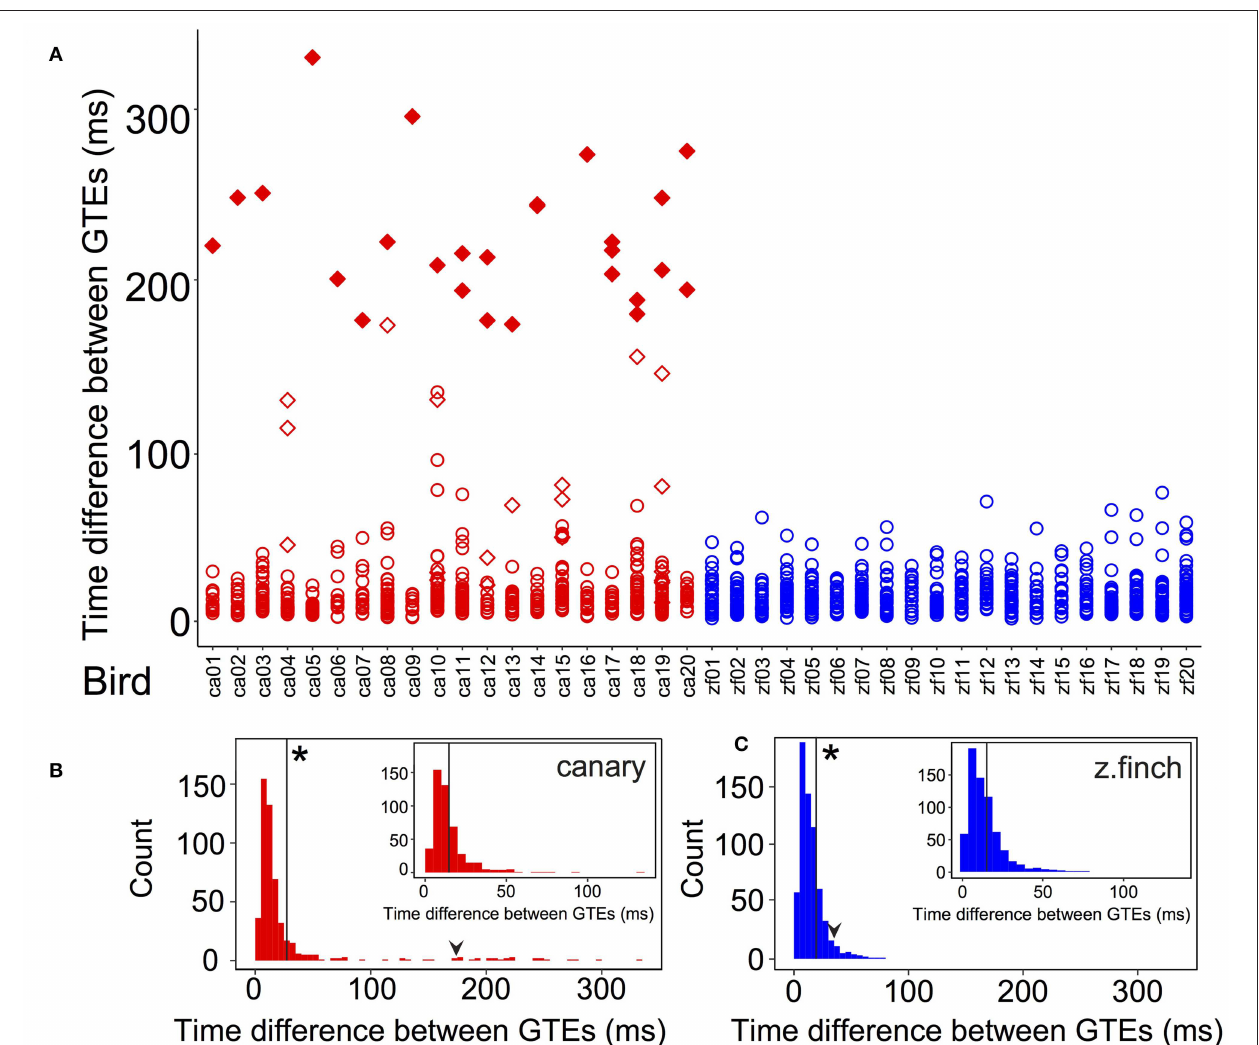
FIGURE 4 | Time differences between GTEs of each bird and grouped by species. (A) Time differences between GTEs for canaries (red markers) and zebra finches (blue markers). In canaries, diamonds indicate that the time difference belongs to a whistle syllable. Note that every canary has at least one diamond. The largest time differences of the canary distribution (in the 95th percentile, larger than 173ms) are indicated with filled markers. Every time difference included in this group was from a whistle. (B) Histogram (5ms bins) of time differences between consecutive GTEs in canaries and (C) in zebra finches. The black arrowheads show the value of the 95th percentile of each distribution (173ms for canaries and 35ms for zebra finches). The vertical black lines show the value of the mean of each distribution: 28.0 ± 2.2ms (mean ± SEM) for canaries ( n = 505) and 15.1 ± 0.4ms (mean ± SEM) for zebra finches ( n = 637). Asterisks in (B,C) indicate that these means were significantly different ( t -test, p < 0.01). In canaries, the longest GTE time interval was 330ms while in finches it was 76ms. The standard deviation was 50.2ms ( n = 505) in canaries and 10.5ms ( n = 637) in zebra finches. These were significantly different (Levene test centering with the median, p < 0.05). (Inset B) Histogram (5ms bins) of time differences between consecutive GTEs in canaries discarding those from whistle syllables. (Inset C) Zebra finch distribution of time differences as in (C) , at the same scale as (Inset B) for comparison. The vertical black lines in the insets show the mean of each distribution. For the new canary distribution, the value was 14.7 ± 0.6ms (mean ± SEM, n = 472). The value for zebra finches is unchanged from (C) . In the new canary distribution, the standard deviation was 12.4ms and the longest GTE time interval was 134ms. The new canary mean and standard deviation were not significantly different from those of zebra finches ( t -test, p > 0.5 and Levene test, p >